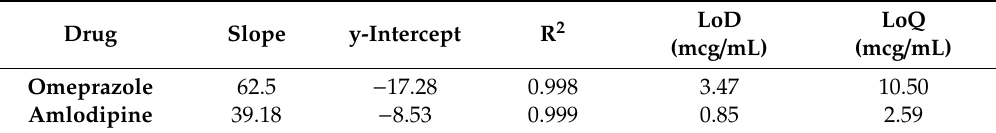
Table1. Calibrationplotpropertiesforomeprazoleandamlodipinequantificationmethodasdetermined by linear regression, correlation analysis and LoD / LoQ for each drug.